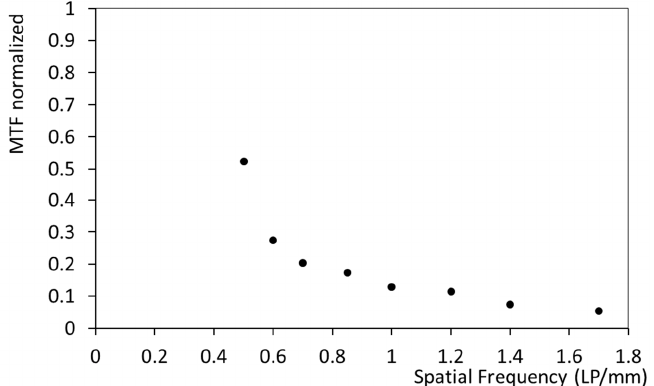
Figure 13 . Measured MTF with mask type 53 by using Equation (2) for the GEMPix detector.